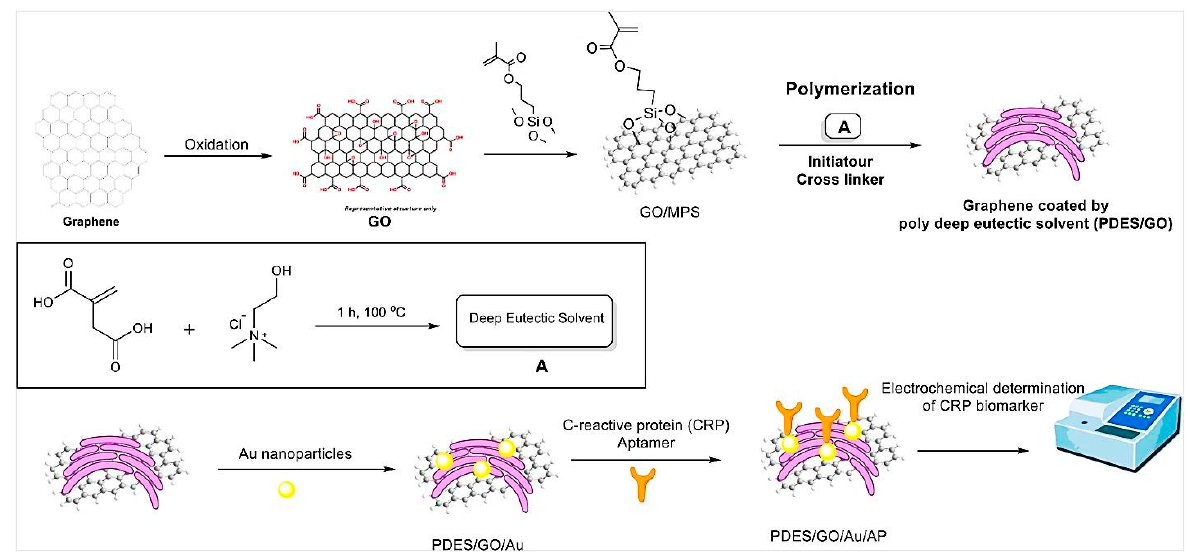
Figure 4. Schematic representation of the fabrication steps for the CRP aptasensor based on GO/PDES/AuNPs. Reprinted from Ref. [37] with permission.